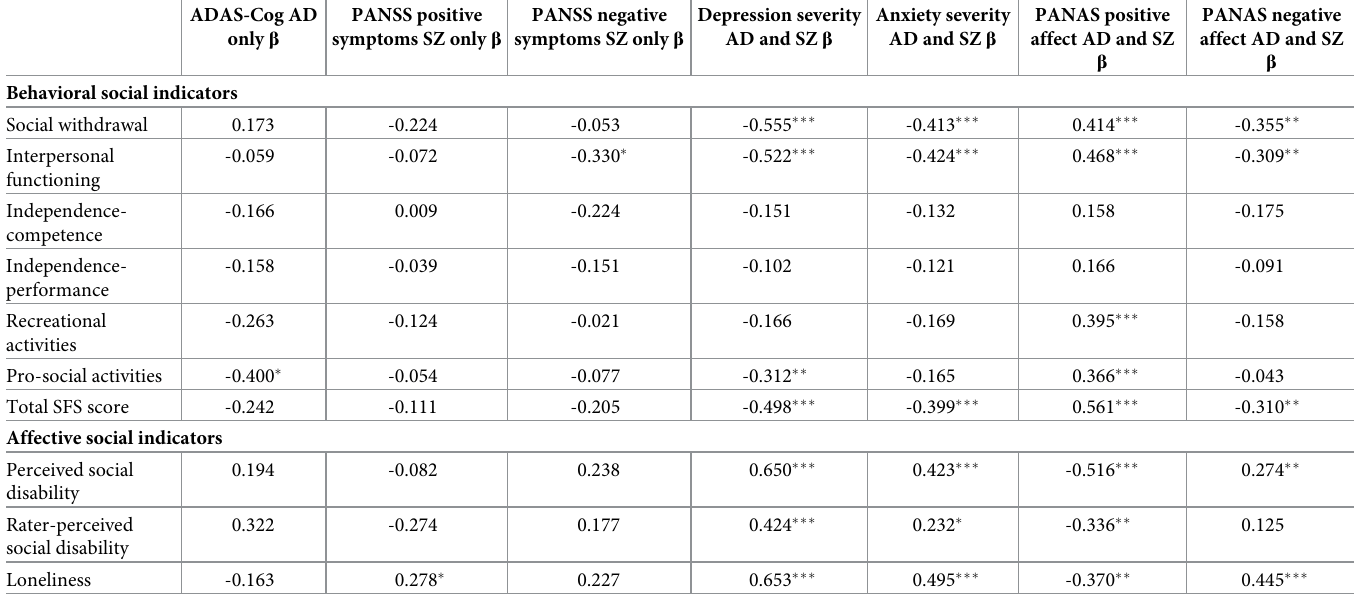
Table 5. Adjusted † associations of clinical characteristics and various social functioning indicators within the group of patients (AD N = 50, SZ = 56). ADAS-Cog AD only